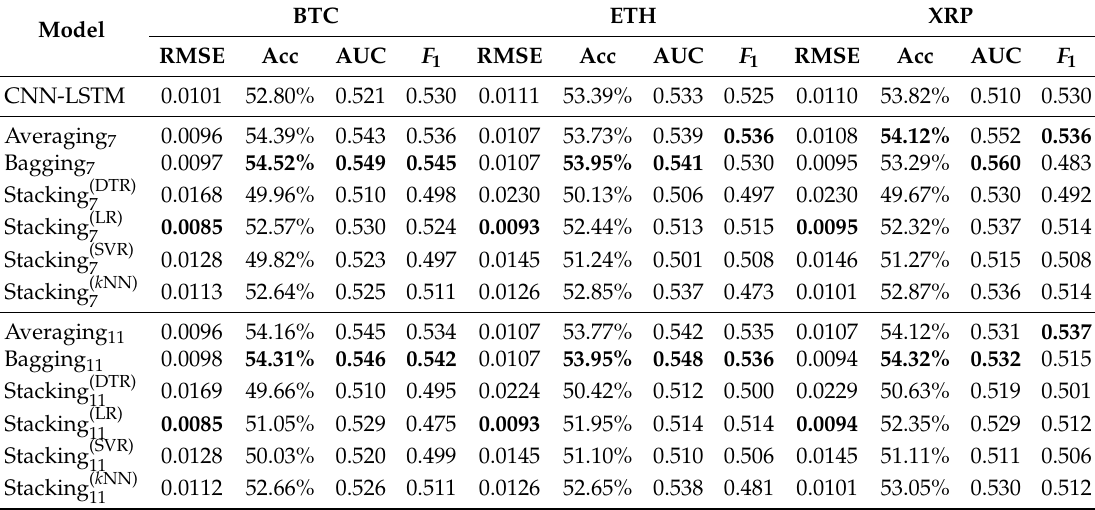
Table 3. Performance of ensemble models using convolutional neural network and long short-term memory (CNN-LSTM) as base learner for m =